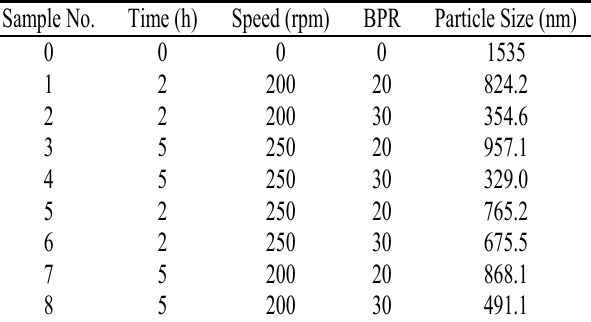
The size of synthesized nano-structured particle by means of DLS analysis in various states of mechanical milling.